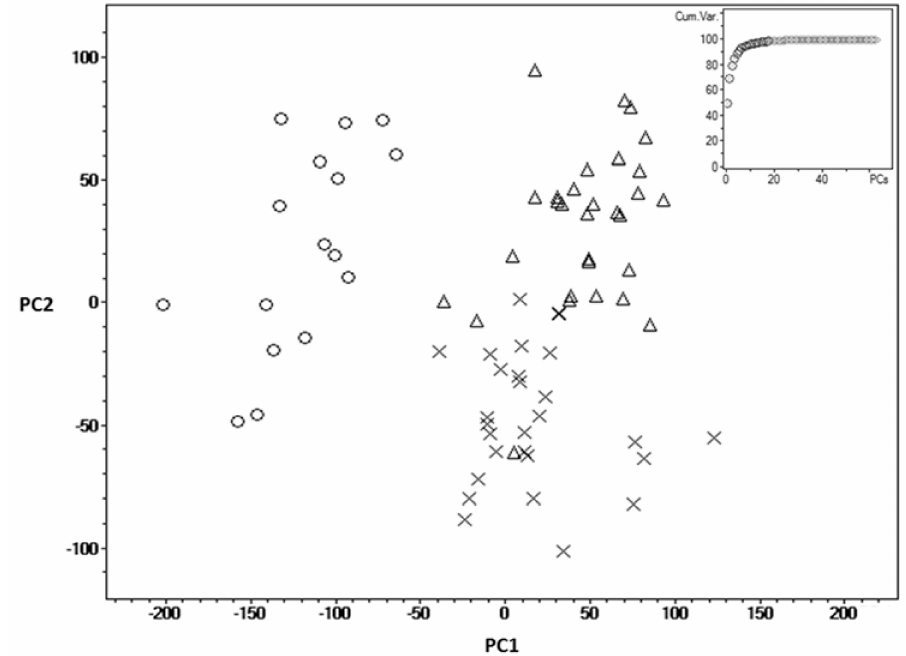
Figure 1. Discriminated PCA results of direct injection quadrupole time-of-flight mass spectrometry with an electrospray interface (source) (DI-ESI-QTOF MS) data. PCA scores plot shows the separation trends among negligible ( Esox Lucius and Acipenser ruthenus ) ( × ), gradual ( Sander lucioperca and Perca fluviatilis ) ( ∆ ) and rapid ( Oncorhynchus keta and Oncorhynchus gorbuscha ) ( Contributions of individual variables to the separation of samples can be identified by corresponding loading plot in the upper right corner of the figure. PC: principal